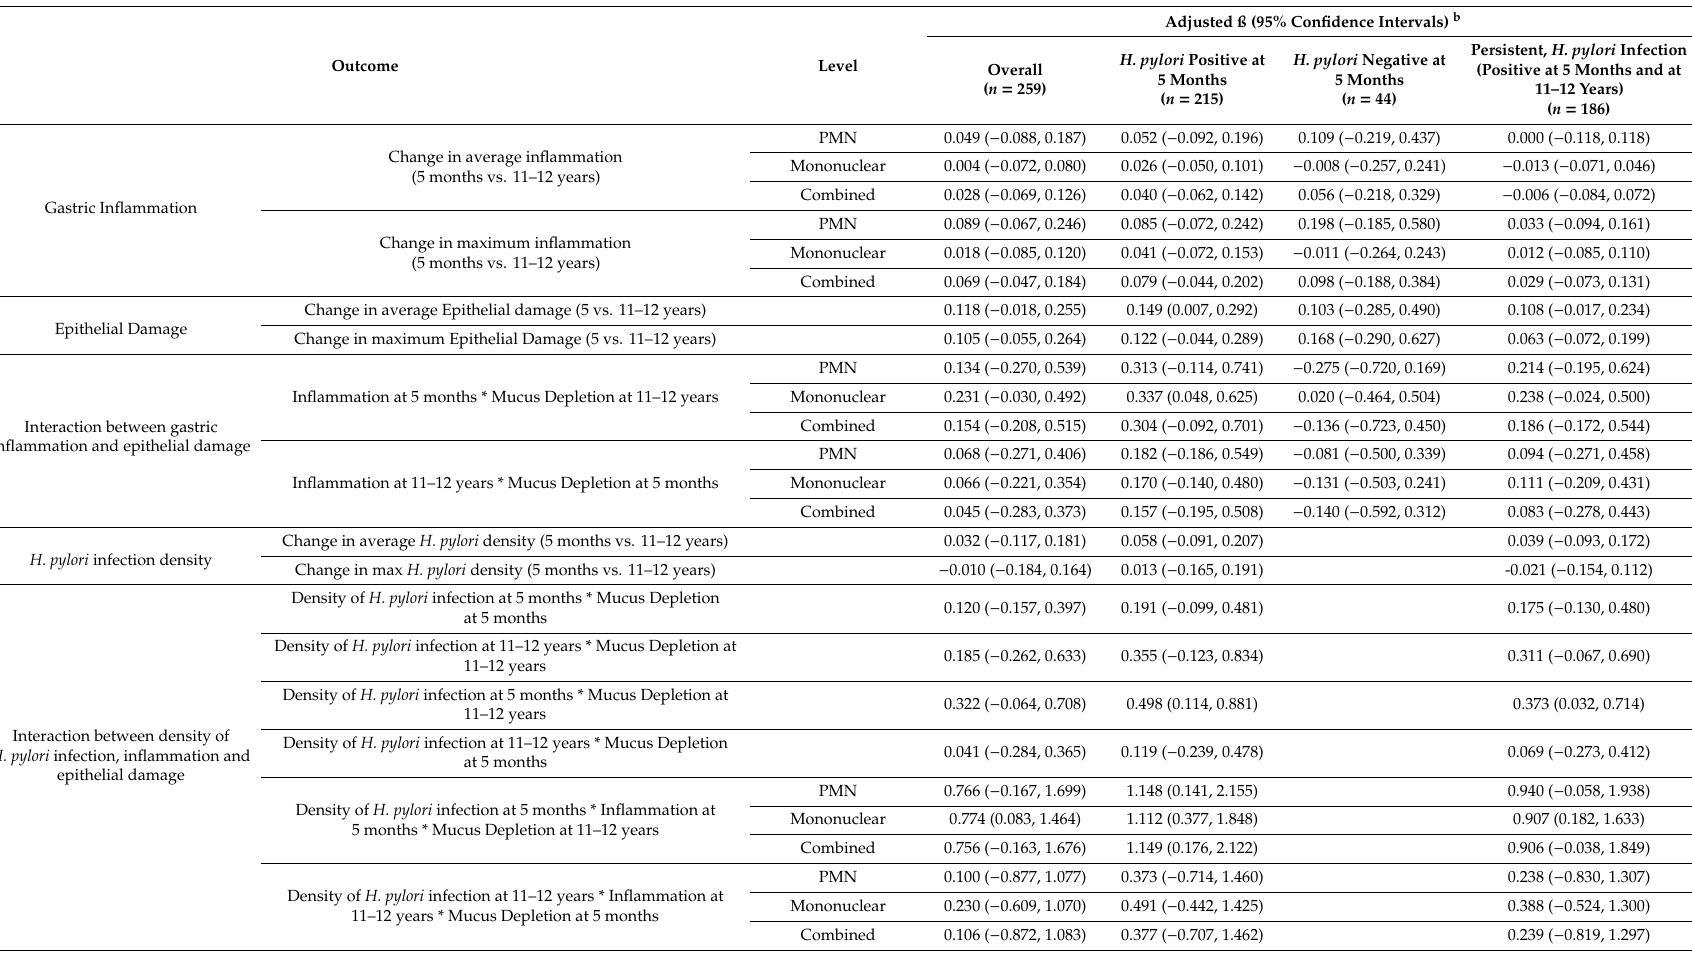
Table 1. Results of linear regression for the estimated e ff ect of salt intake measured as the average of baseline and five-month measures of the urinary sodium / creatinine ratio at baseline on gastric inflammation and epithelial damage a